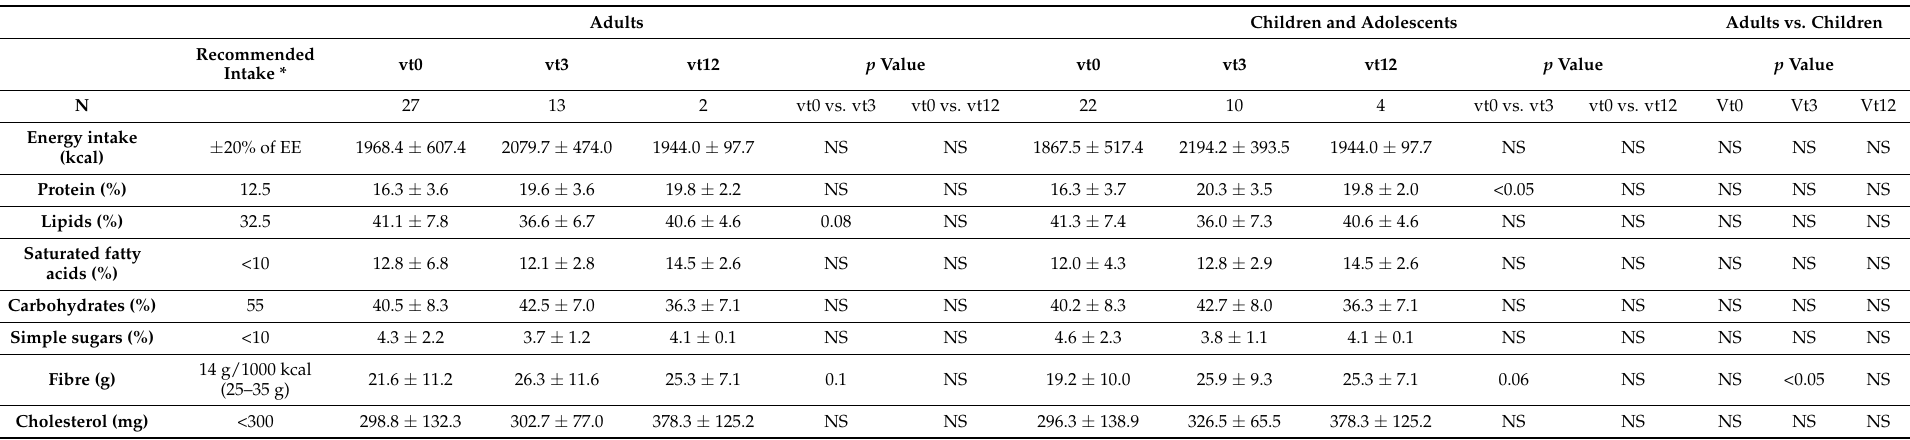
Table 1. Energy and macronutrient daily intake of celiac adults and children (mean ± SD). Adults Children and Adolescents Adults vs. Children